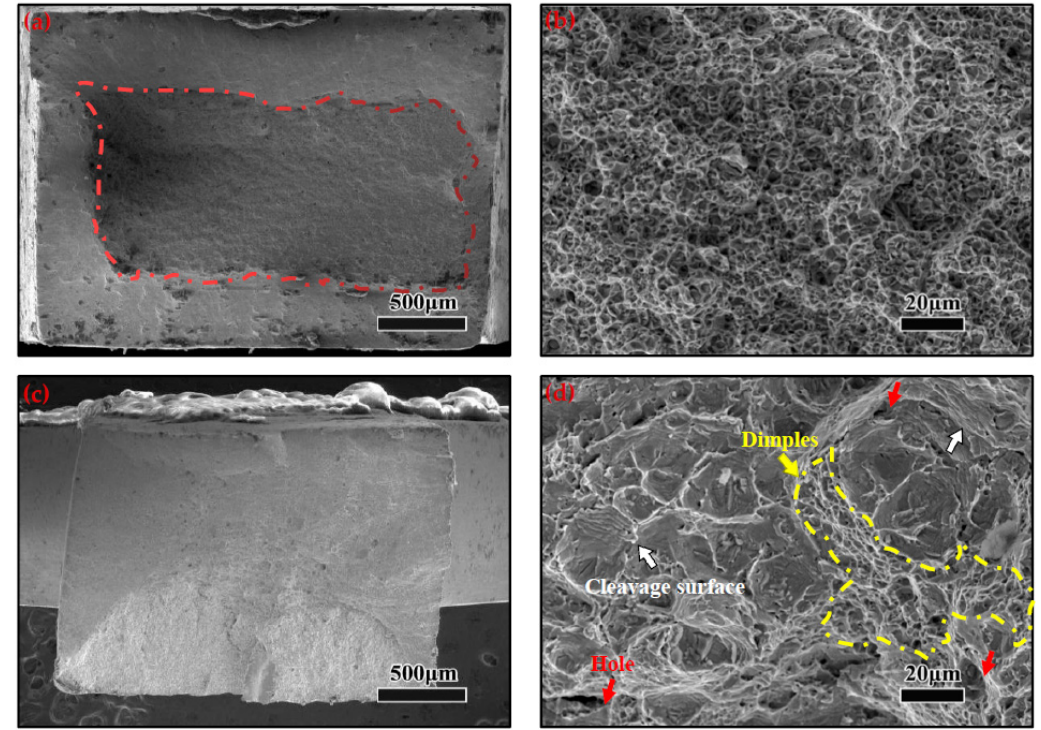
Figure 9. ( a , b ) Macro- and microfracture morphology of the tensile test temperature at RT, ( c , d ) Macro- and microfracture morphology of the tensile test temperature of 750 °C.